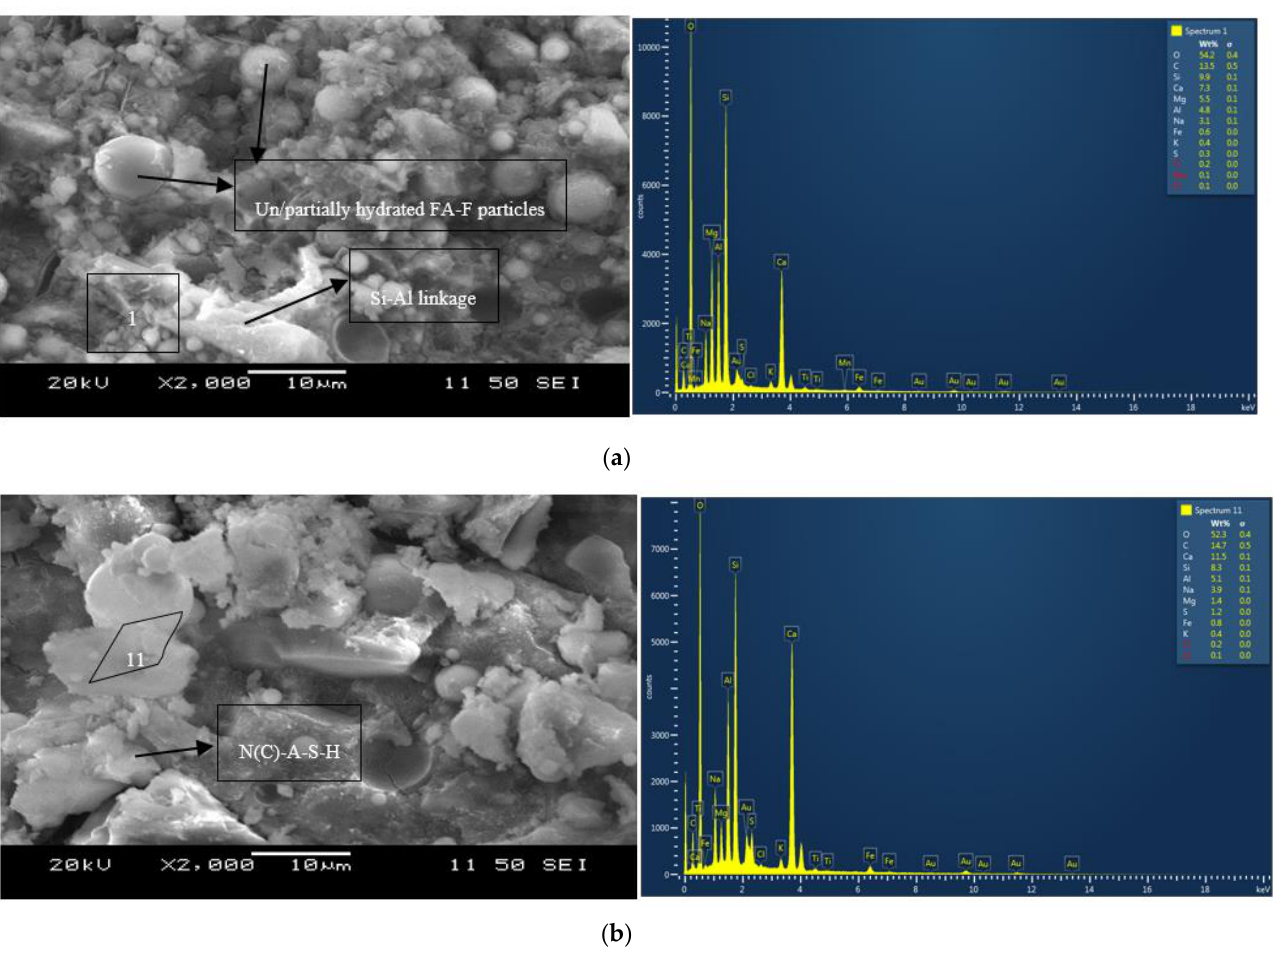
Figure 11. ( a ) SEM micrographs and EDS analysis of the ternary binder CFS-4-1. ( b ) SEM micrographs and EDS analysis of the ternary binder CFS-5-2.